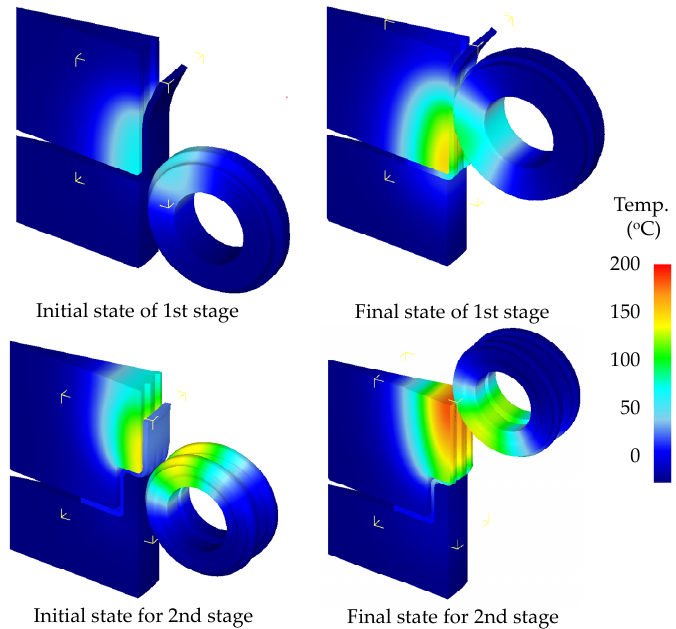
Figure 9. The predicted thickness for the 5th product.